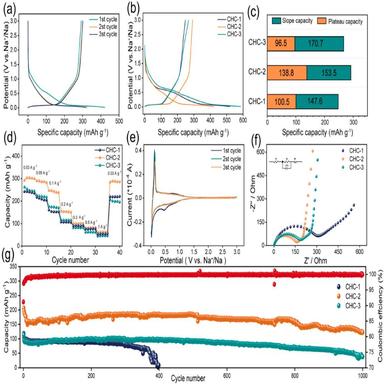
(a) GCD curves at 30 mA g− 1 of CHC-2 for the initial three cycles. (b) Initial GCD curves of CHC samples. (c) Comparison of plateau capacity and slope capacity foe CHC; (d) Rate capability of CHC samples. (e) CV curves of CHC-2 at a scan rate of 0.1 mV− 1 . (f) Nyquist plots and (g) cycling performance of all sample electrodes.